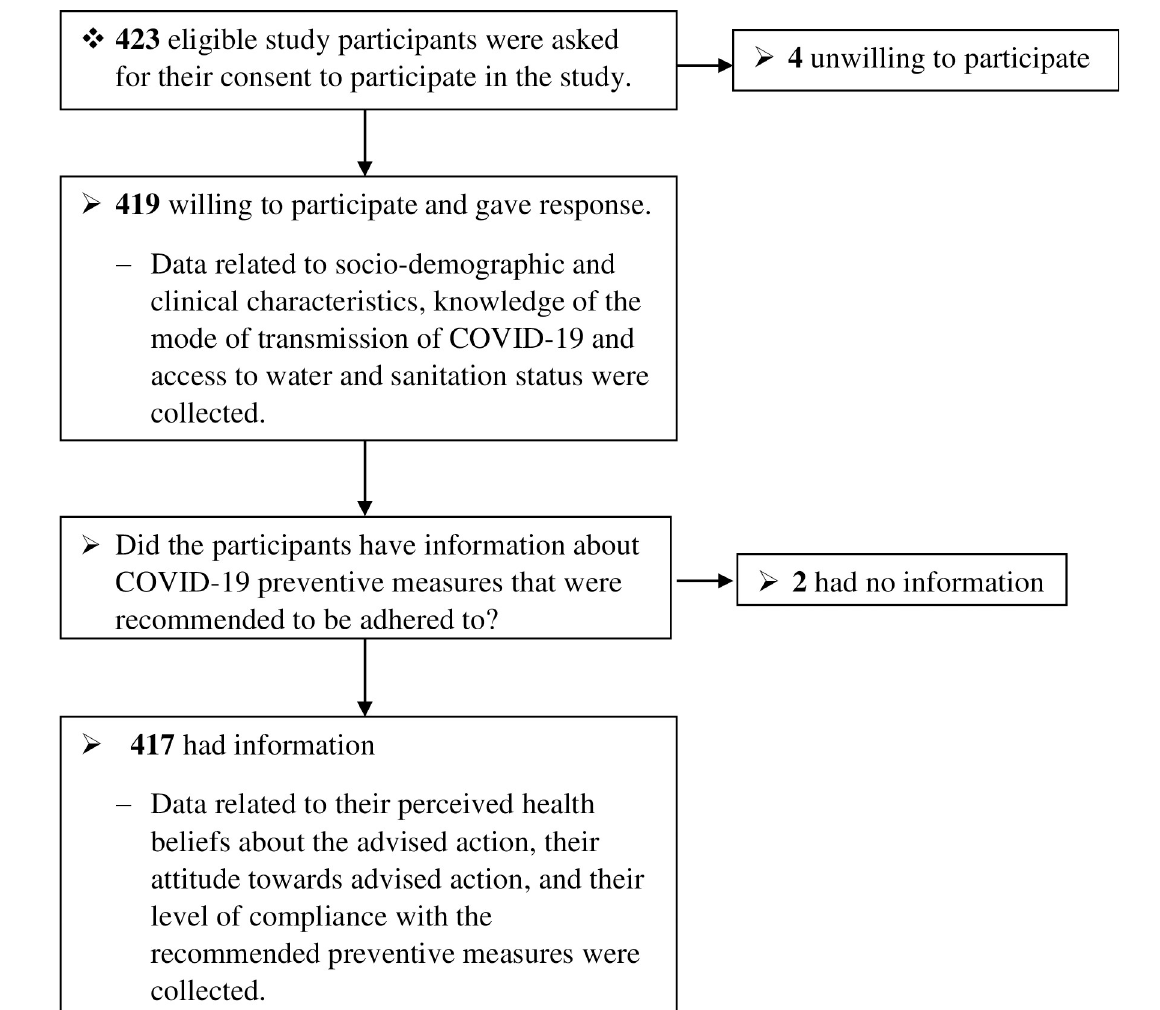
Fig 1. Flow diagram showing the recruitment process of study